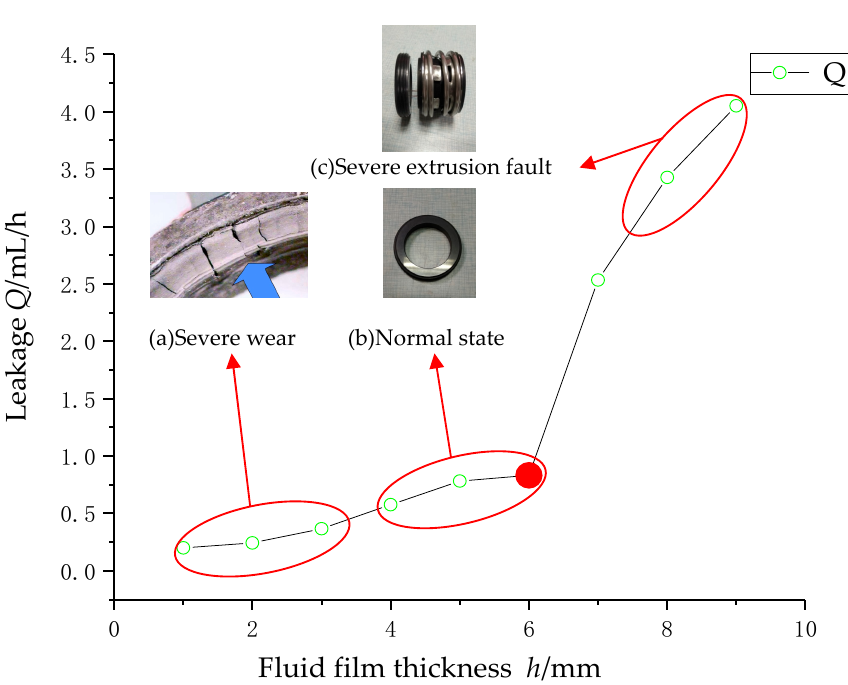
Figure 15. Leakage under different fluid film.